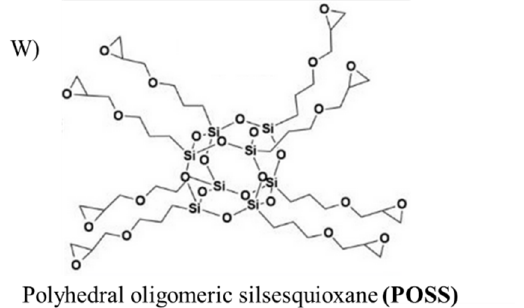
Figure 1. Chemical structures and full names of reagents presented in Table 1. The POSS figure comes from Journal of Power Sources, 2020.